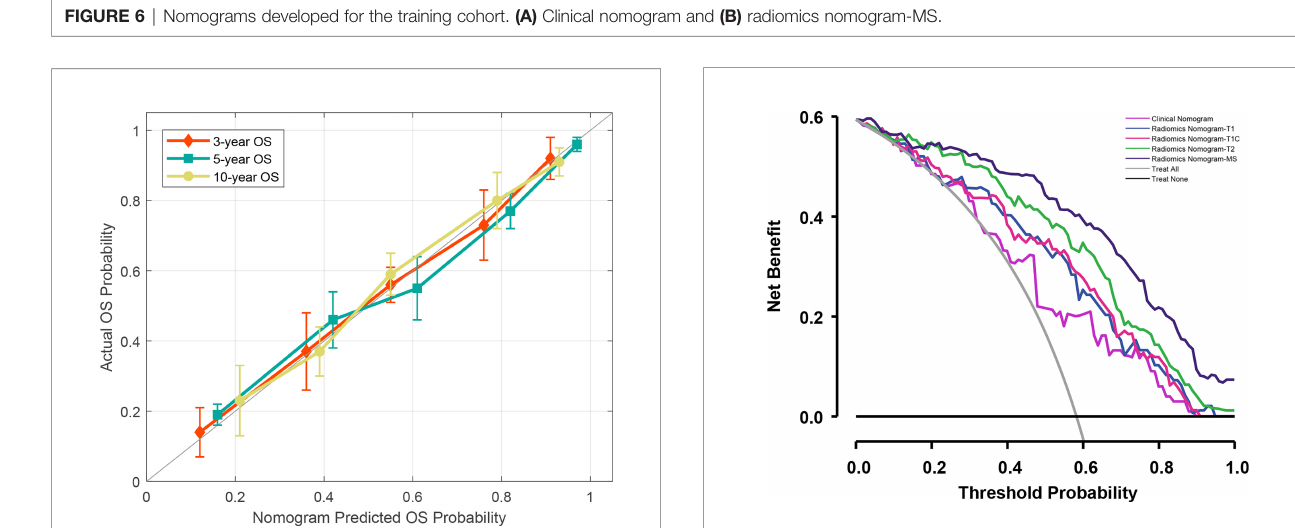
FIGURE 7 | Calibration curve for the radiomics nomogram-MS.